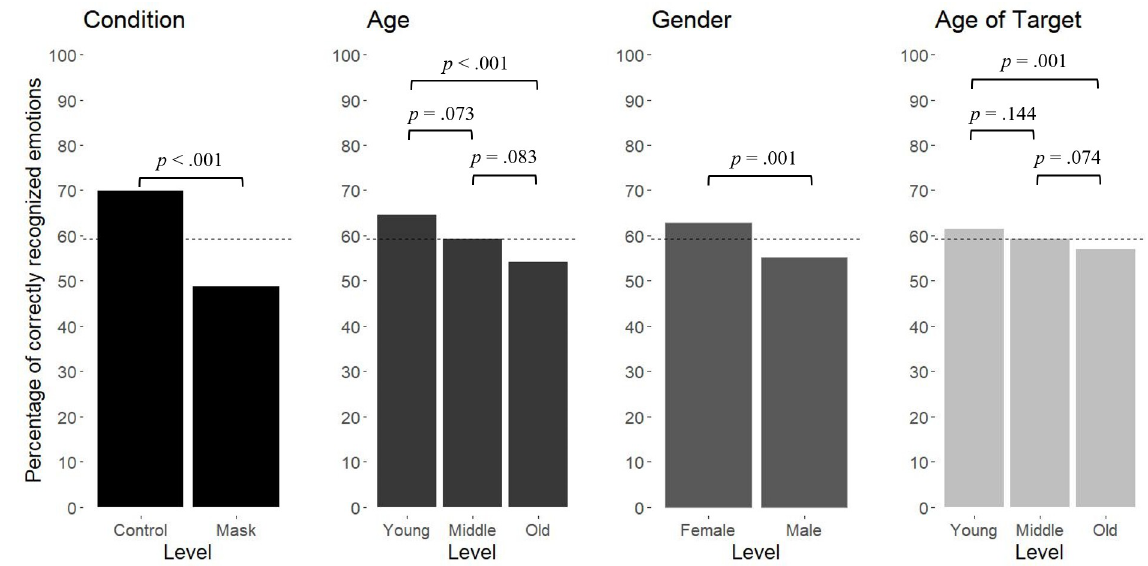
Fig 2. Factor-based comparisons of emotion-recognition accuracy. Comparisons are based on simple multilevel logistic regression models with emotion-recognition accuracy as the outcome and the respective factor as the sole predictor. For factors with three levels, we repeated the analysis using the level initially coded as 010 as the reference group. The dashed line indicates the average emotion-recognition accuracy across trials, participants, and factors ( ^ r = j